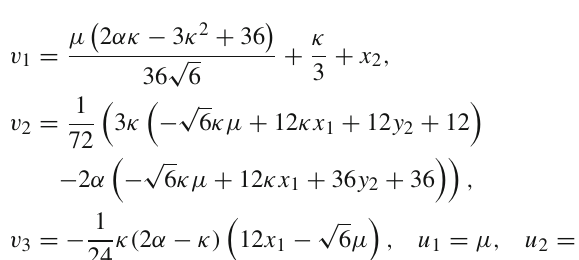
From Eq. (53a)which the center is unstable to perturbations along the u 1 -axis (saddle behavior). This is due to (53a) which is a gradient like